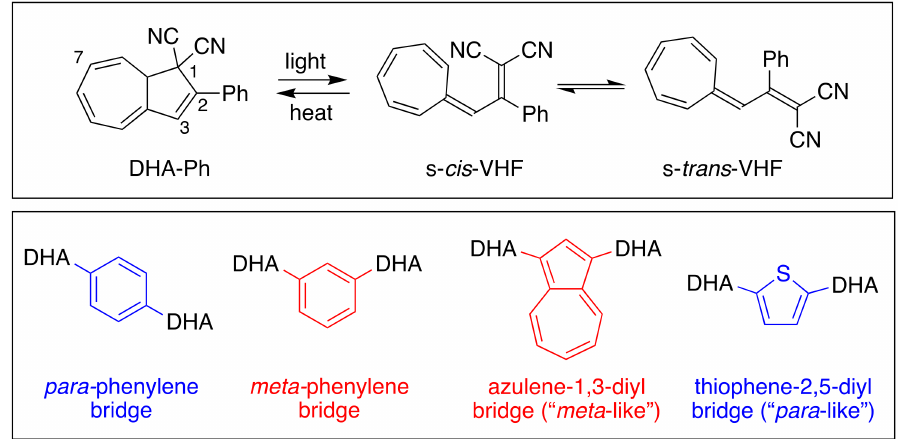
Figure 1. DHA-Ph/VHF-Ph monomer couple (top); previously reported meta - and para -connected DHA-based dimers (bottom).